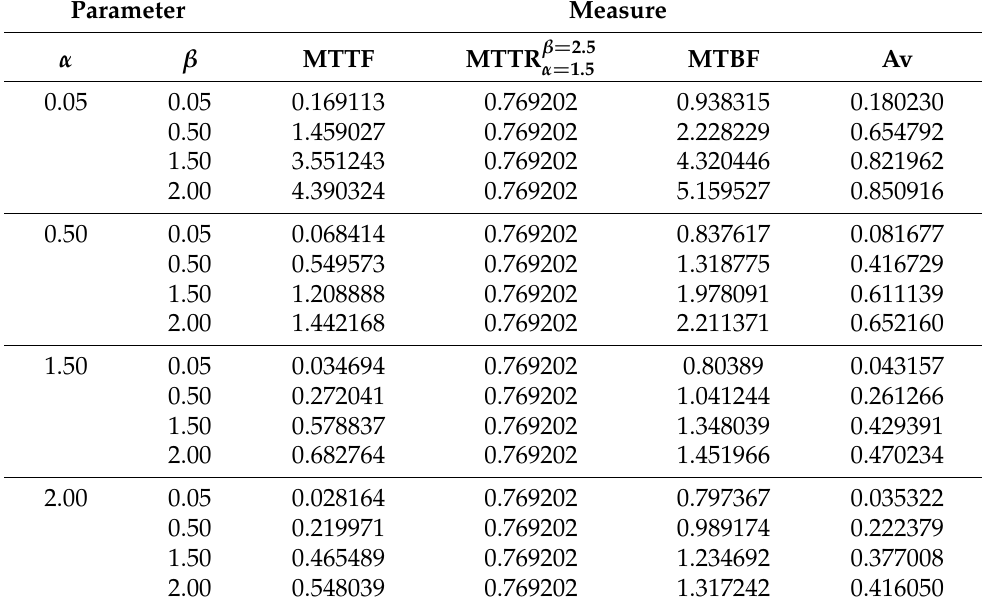
Table 2. Some reliability computations of the EBuH